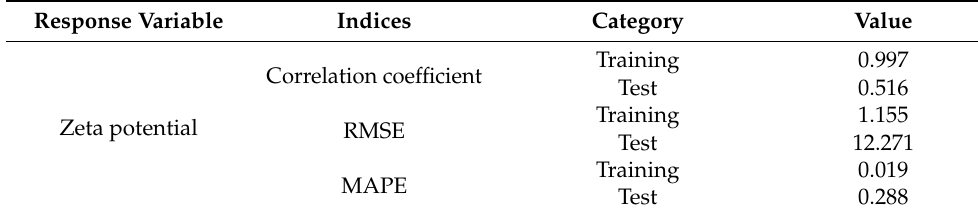
Figure 3. Actual and predicted zeta potentials from SVM (training and test data). Table 3. SVM model performance